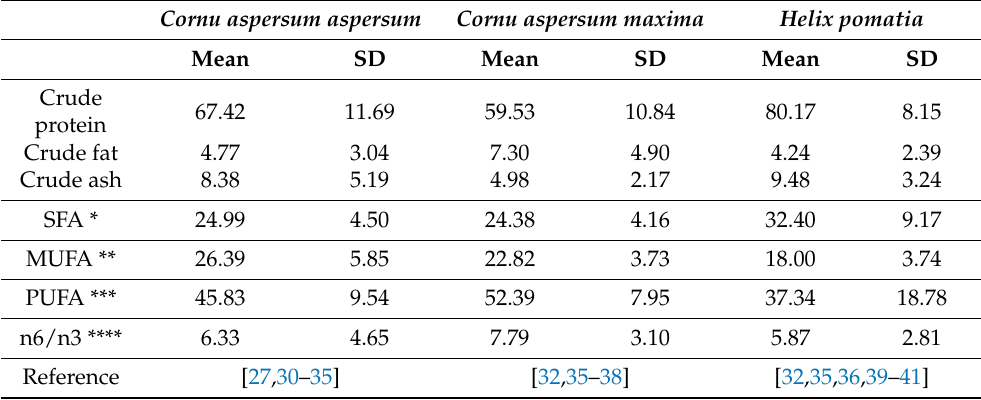
Table 1. The mean composition values of various snail meats (% of DM) and the composition of the main group of fatty acids in the meat of edible snails (% share in total fat). Cornu aspersum aspersum